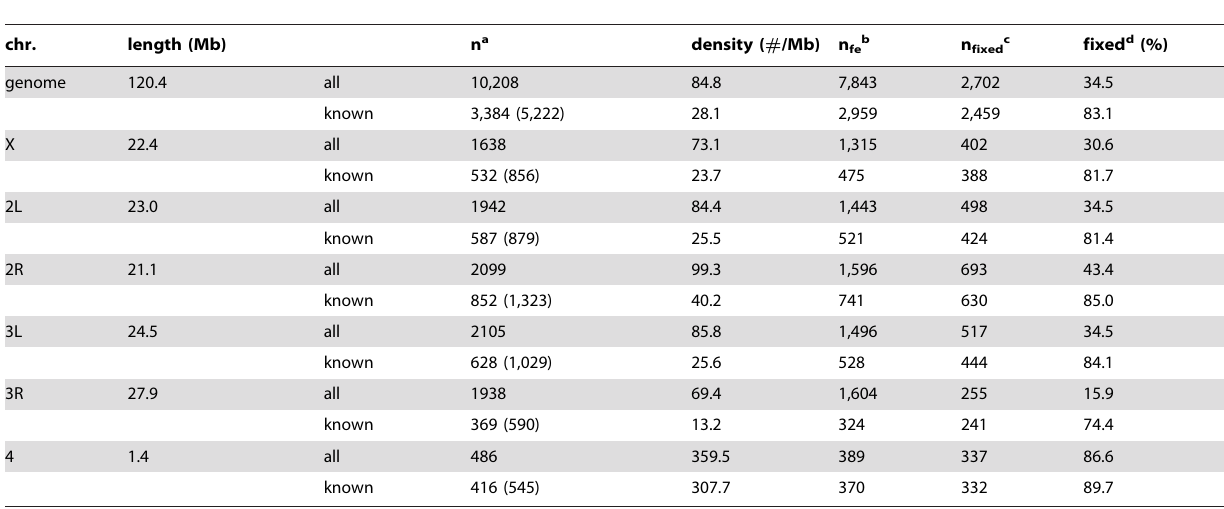
Table 1. Abundance of TE insertions in the chromosomes of D. melanogaster .